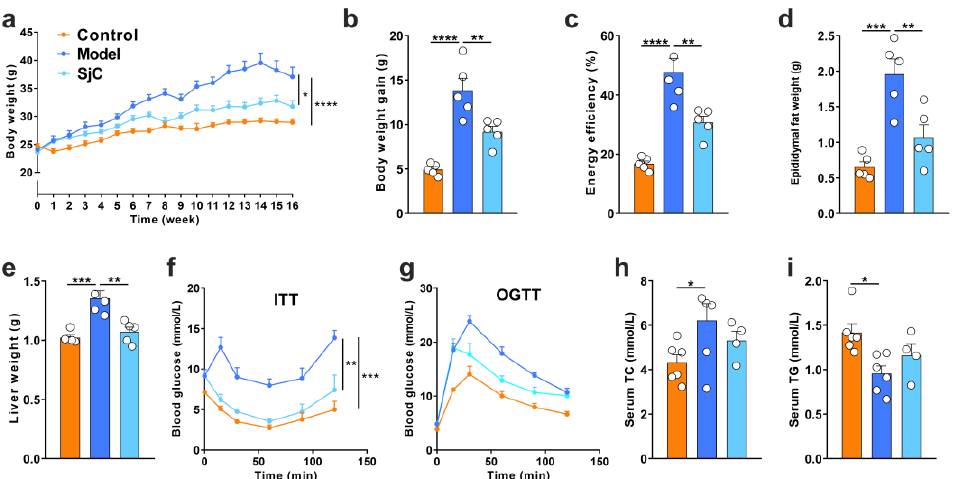
Figure 1. SjC supplementation prevented HFD-induced obesity and metabolic disorders. ( a ) Body- weight. ( b ) Bodyweight gain. ( c ) Energy efficiency. ( d ) Epididymal fat weight. ( e ) Liver weight. ( f ) Blood glucose curves after intraperitoneal injection of insulin. ( g ) Blood glucose curves after an oral load of glucose. ( h ) Serum total cholesterol. ( i ) Serum triglycerides. All data are expressed by mean ± SEM ( n = 3 – 6). One-way ANOVA and Tukey multiple comparison analysis were used to analyze the significance between multiple groups, * p < 0.05; ** p < 0.01; *** p < 0.001; **** p < 0.0001.